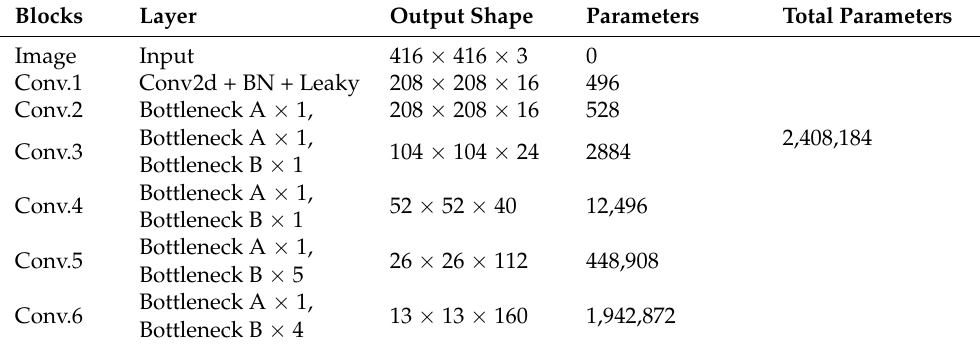
Figure 3. Two bottleneck structures based on ghost modules. ( a ) Bottleneck A, ( b ) bottleneck B. Table 3. Details of the processes in Step 1.